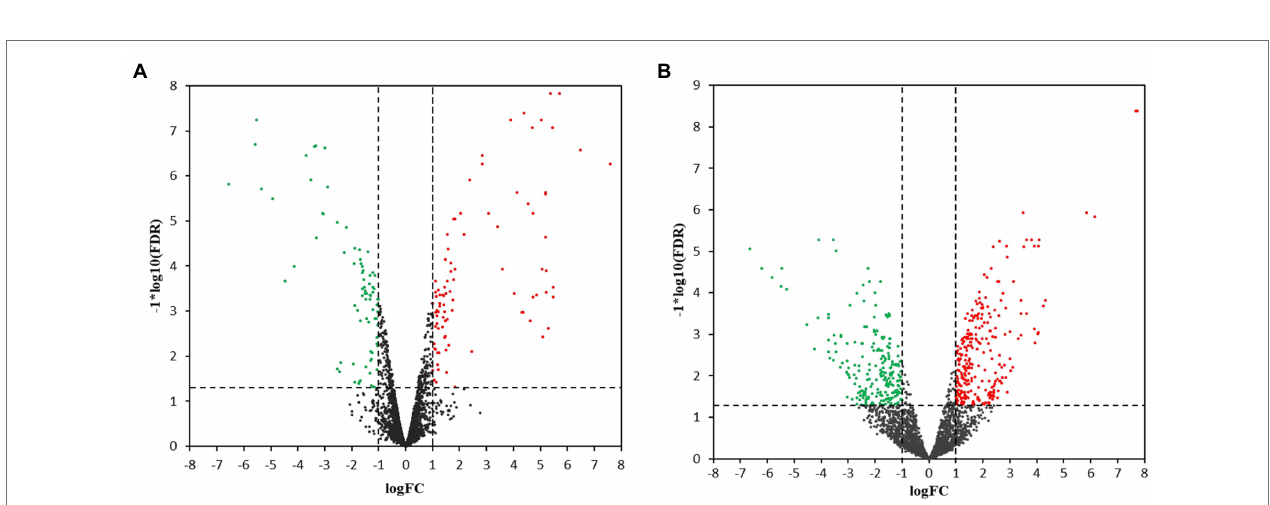
FIGURE 1 | Response of the differentially expressed genes (DEGs) to olive leaf extract (OLE) treatment in Listeria monocytogenes. DEGs shown to be upregulated at (A) 3.5 h and (B) 24 h post-OLE treatment are displayed in red whereas those shown to be downregulated are blue in